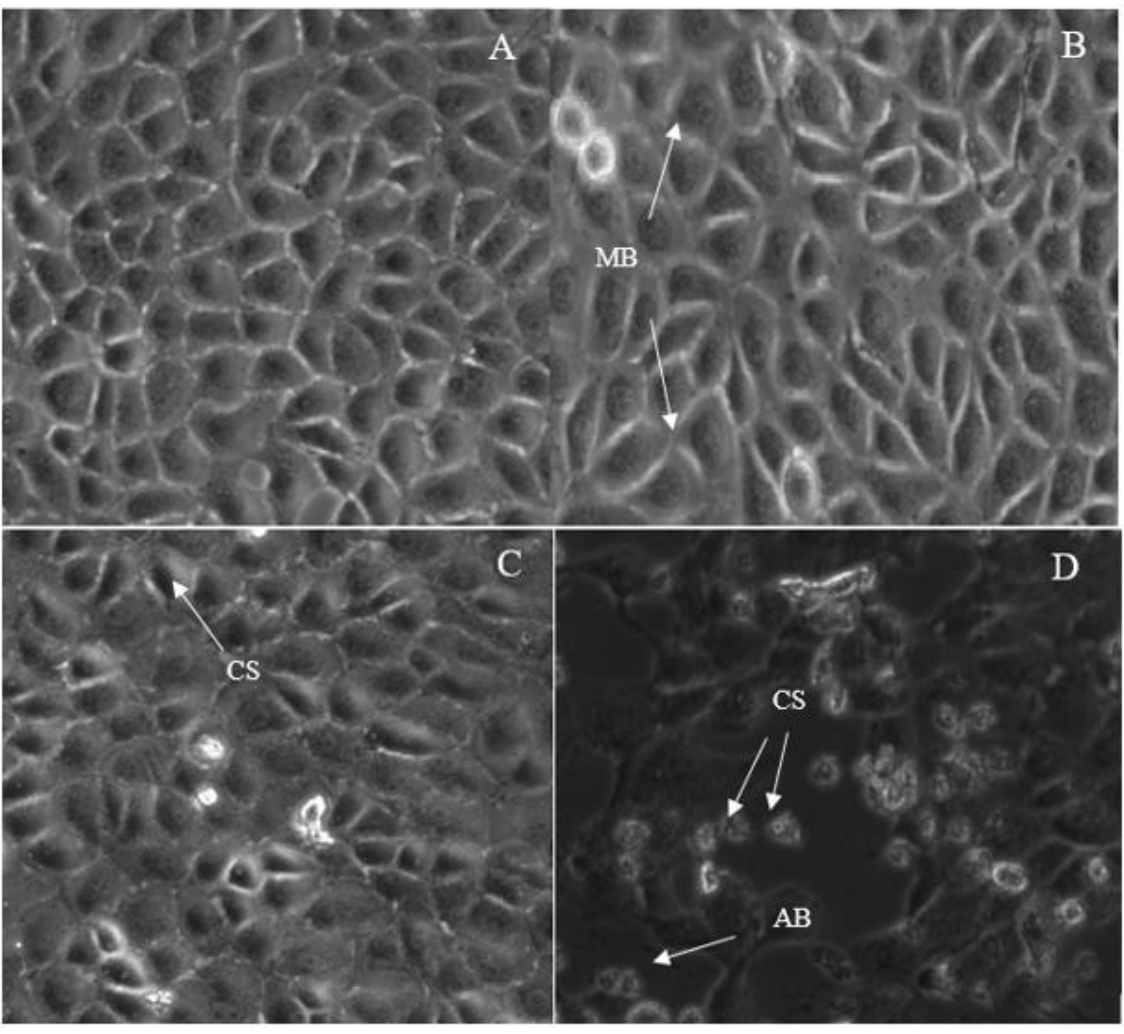
Figure 14. Morphological changes of treated MDA-MB-231 cells observed under phase contrast microscope (200× magnification). Untreated cells ( A ), treated cells 24 h ( B ), 48 h ( C ), and 72 h ( D ). Cell population decreased with the incubation time. The cells showed the features of apoptosis such as membrane blebbing (MB), cellular shrinkage and rounding (CS) and formation of apoptotic bodies (AB).